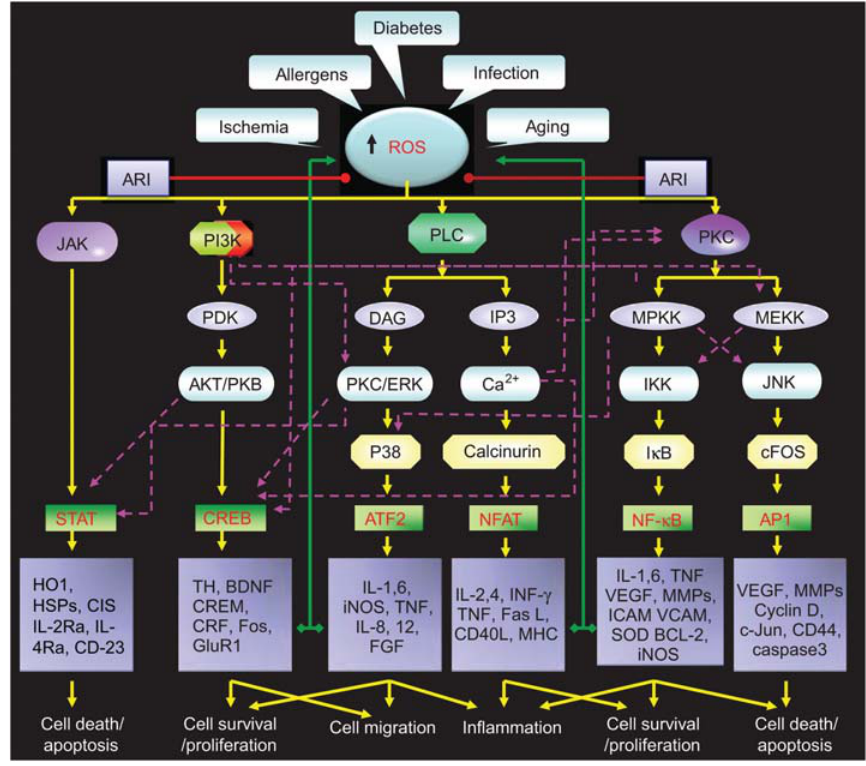
Figure 3 Aldose reductase prevents inflammatory complications by preventing the oxidative stress-induced inflammatory signals down- stream to reactive oxygen